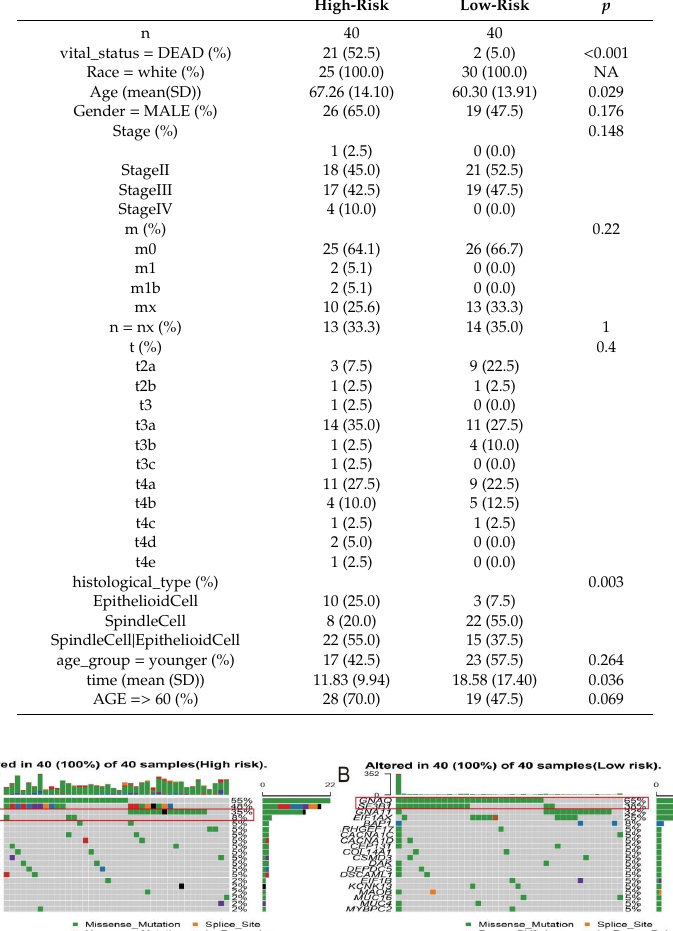
Table 2. The subgroups analysis of clinical characteristics between low- and high- risk groups. The results indicated that UM patients in high-risk have older age, shorter living time and more epithelioid cell type than low-risk (chi-square test p < 0.05).